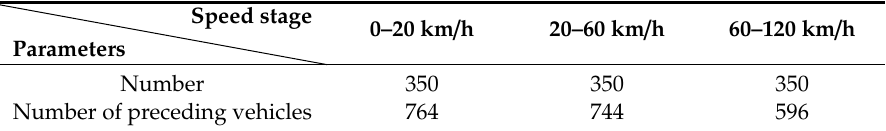
Table 3. Parameters of screened images at different speed stages.